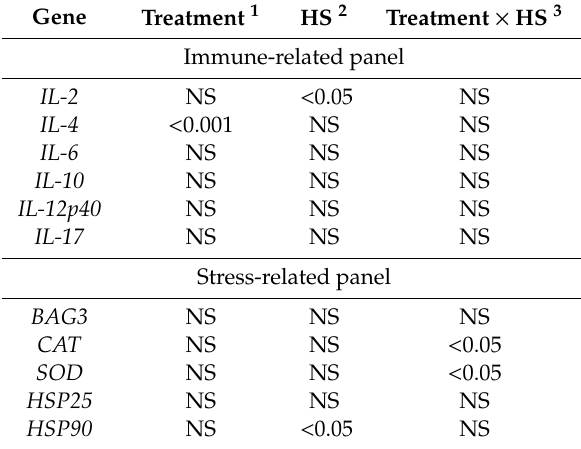
E ff ects: 1 In ovo delivery of galactooligosaccharides (GOS) vs. physiological saline (C); 2 HS (acute HS vs. chronic HS); 3 interaction between in ovo treatment and ambient temperature on immune-related and stress-response